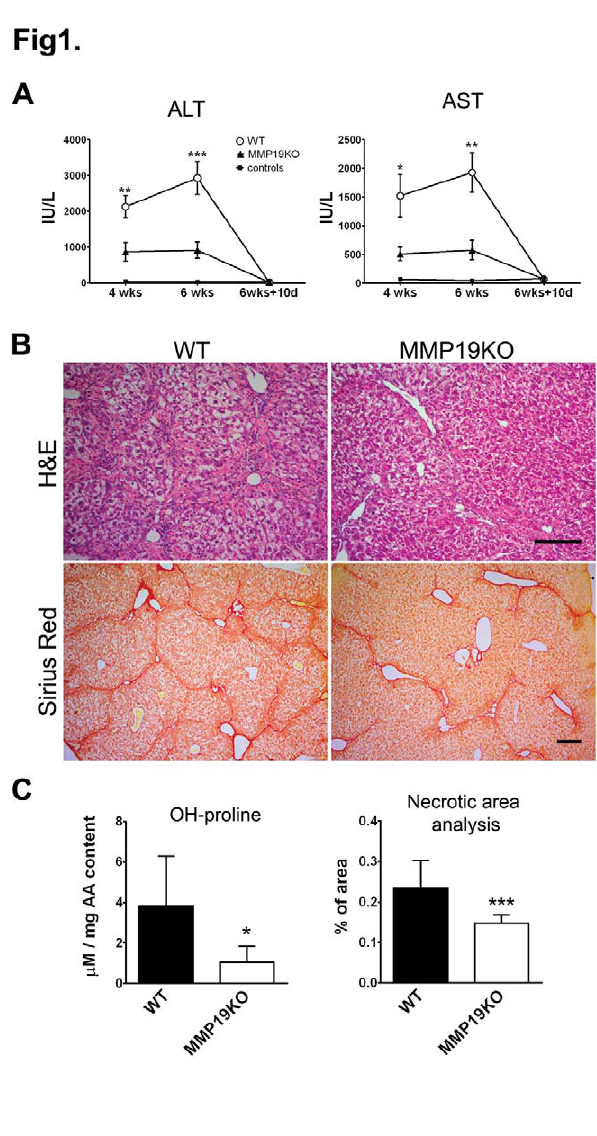
Figure 1. 6 week CCl 4 treatment results in lower liver damage in MMP19KOs compare to WTs. (A) After 4 and 6 week treatment with CCl 4 , serum ALT and AST levels were significantly lower in MMP19KO than in WT mice. WT mice treated with olive oil are shown as control mice. (B) H&E staining showed larger bridging necrosis areas in WTs than in MMP19KOs. Sirius red staining showed more fibrillar collagen deposition in WTs than in MMP19KOs. (C) Liver hydroxyproline (OH-proline) content and image analysis of necrosis areas in H&E stained liver sections showed significantly more extensive damage in WTs than in MMP19KOs. Images were originally taken at 100 6 (H&E) and 50 6 (Sirius Red) magnification, scale bars=200 m m. *p , 0.05; **p , 0.01; ***p , 0.001 MMP19 vs. WT mice; n=6 olive oil controls, 7 WT and 9 MMP19KO